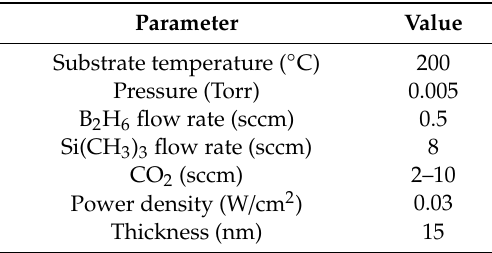
Table 1. Deposition parameters for a-SiO x